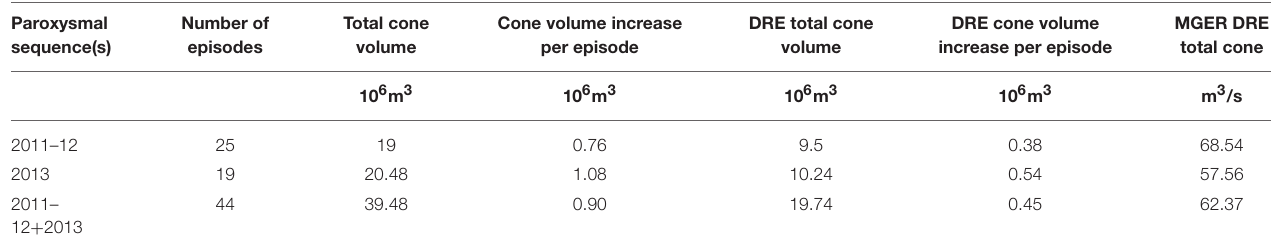
TABLE 1 | Volcanological parameters of the NSEC cone during the 2011–12 and 2013 lava fountaining sequences. Paroxysmal